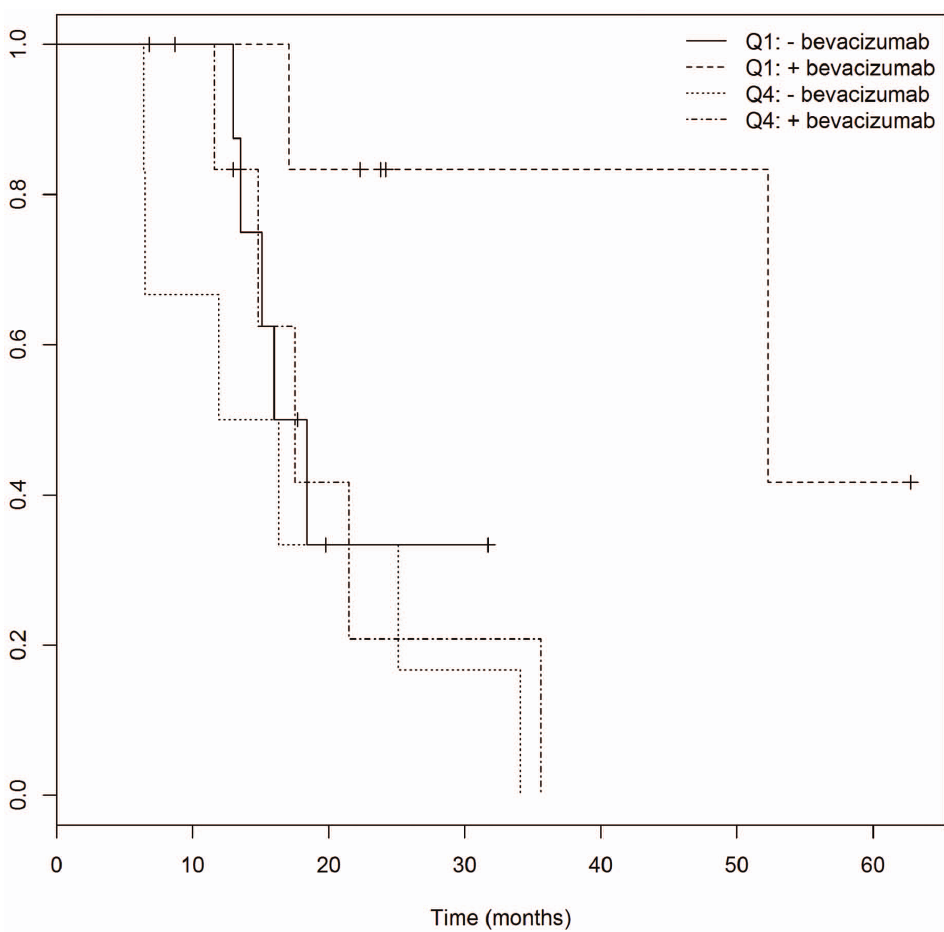
Figure 4. The median OS for the group of patients with the smallest GTV1 tumors who also received bevacizumab (Q1: + bevacizumab) was 52.3 months, compared to 17.2 months for patients with the smallest tumors without bevacizumab (Q1: 2 bevacizumab), 17.5 months for patients with the largest tumors receiving bevacizumab (Q4: + bevacizumab), and 14.1 months for patients with the largest tumors not receiving bevacizumab (Q4: 2